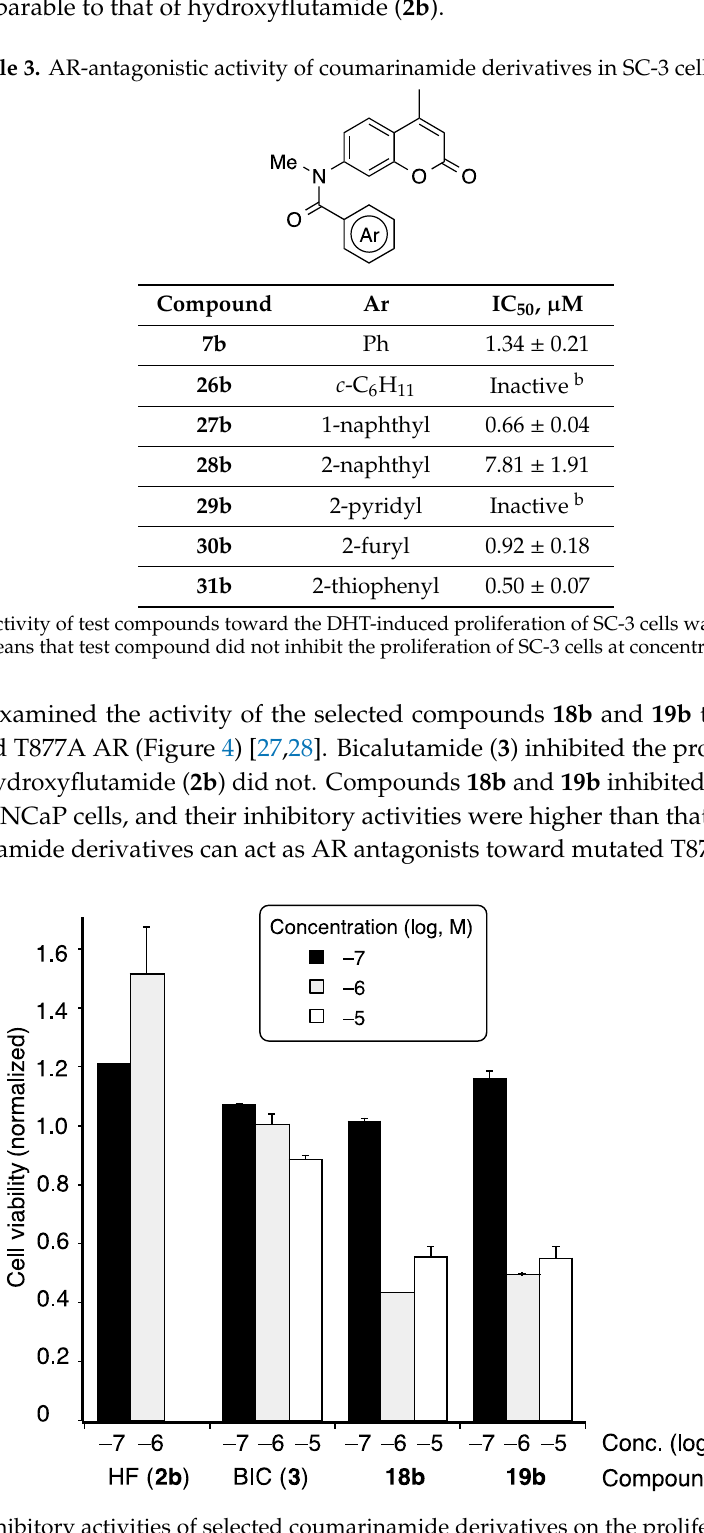
Figure 4. Inhibitory activities of selected coumarinamide derivatives on the proliferation of LNCaP cells with T877A AR. Cell viability was determined by the WST method and normalized to that of vehicle-treated cells, taken as 1.